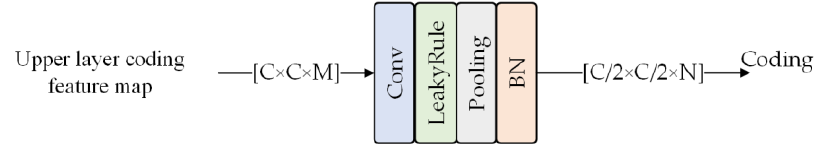
Figure 2. Structure of the generator. Figure 3. Structure of the encoding module.